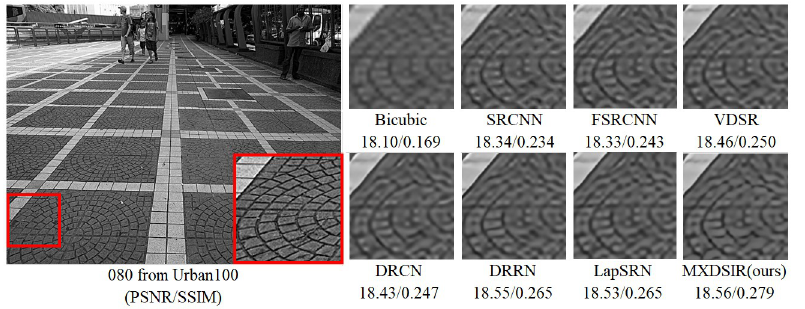
Fig 6. Visual performance of images with 8 × enlargement factor of image 080 from Urban100 dataset.